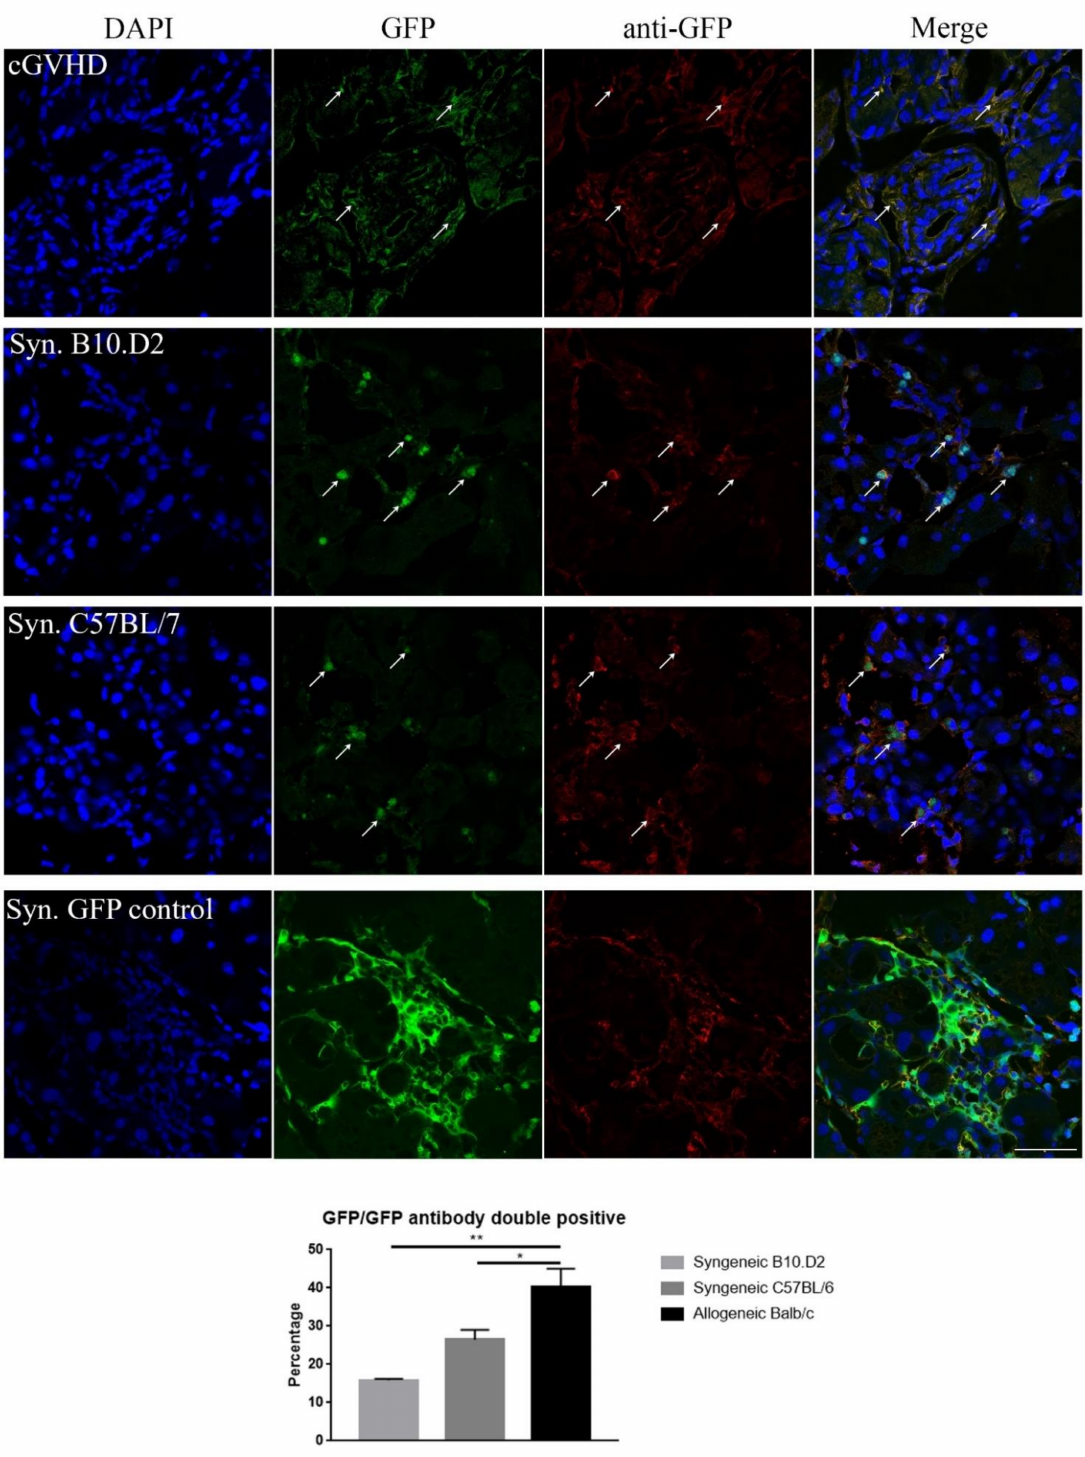
Figure 3. GFP control staining for the lacrimal gland tissue. Anti-GFP staining in allogeneic (top, n = 7), syngeneic (center, C57BL/6 n = 7, B10.D2 n = 3), and GFP + whole bone marrow syngeneic (positive control, bottom) mice. Arrows indicate GFP signals. DAPI (blue), GFP (green), collagen type I (red), and double positive cells (yellow). Scale bar = 50 µ m, 400 × magnification. Bar diagram displays mean ± SEM, * p < 0.05, ** p <